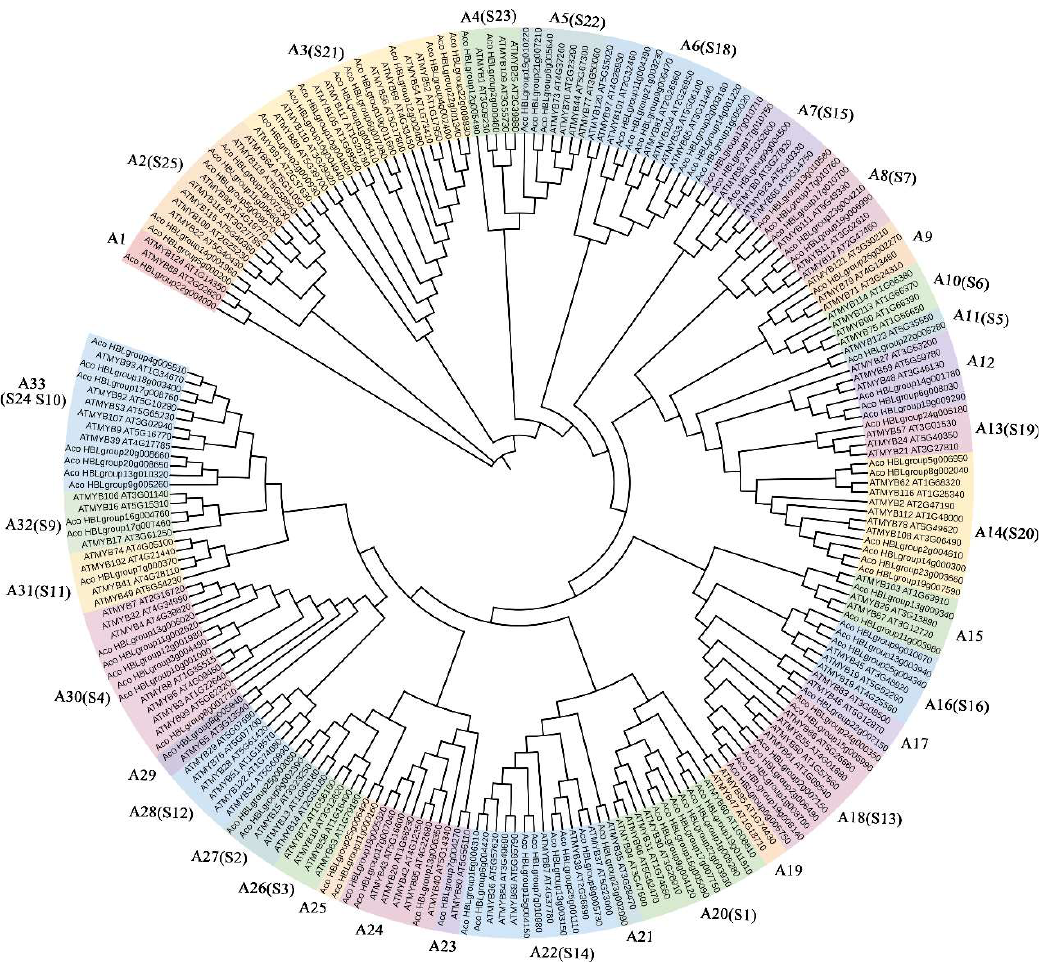
Figure 1. A neighbor-joining phylogenetic tree of R2R3-MYBs of A . comosus var. bracteatus and Ara- bidopsis thaliana . Arabidopsis thaliana